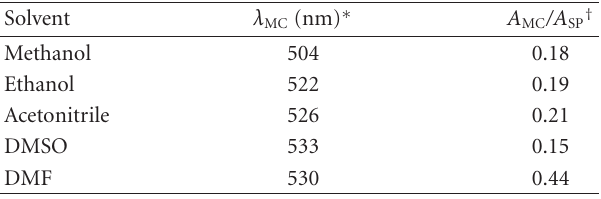
Table 1: Absorption maxima, ratio of absorbances of SP and trans- MC isomer in di ff erent solvents.